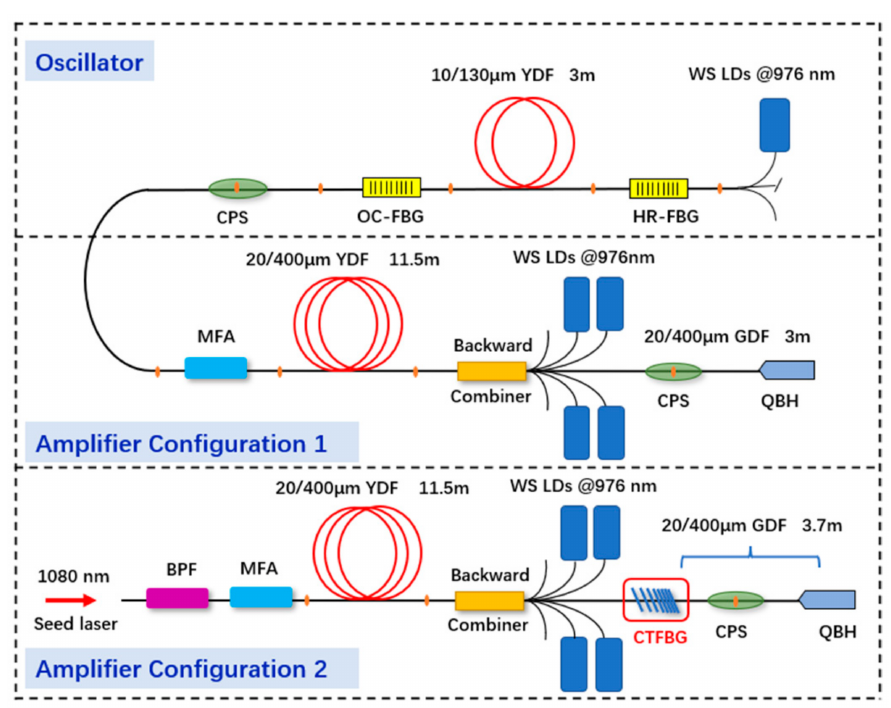
Figure 1. Experimental setup of the all-fiber oscillator one-stage amplification high-power narrow linewidth fiber laser (WS LD: wavelength stable laser diode; YDF: Yb-doped fiber; GDF: germanium- doped fiber; CPS: cladding power stripper; QBH: quartz block